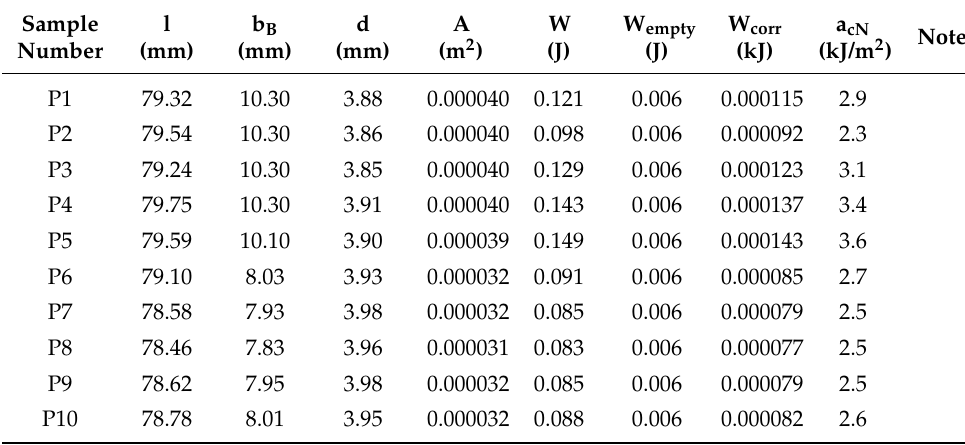
Table A14. Results of the notched impact tests and unnotched impact tests of P_PS.